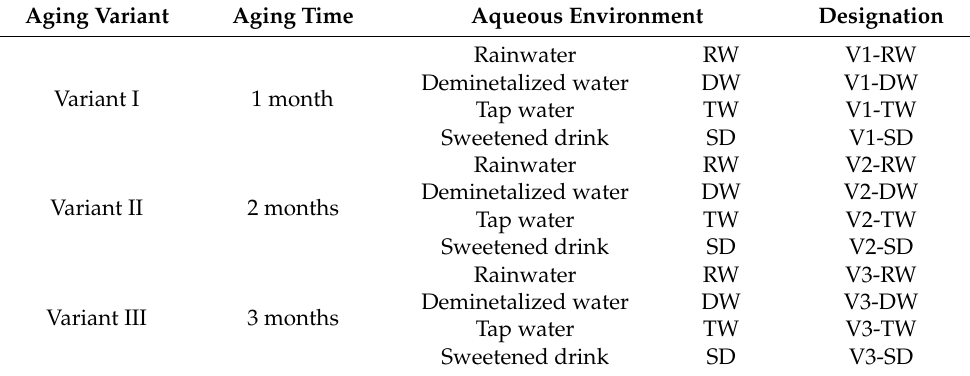
Table 4. Characteristics of the aqueous environments.